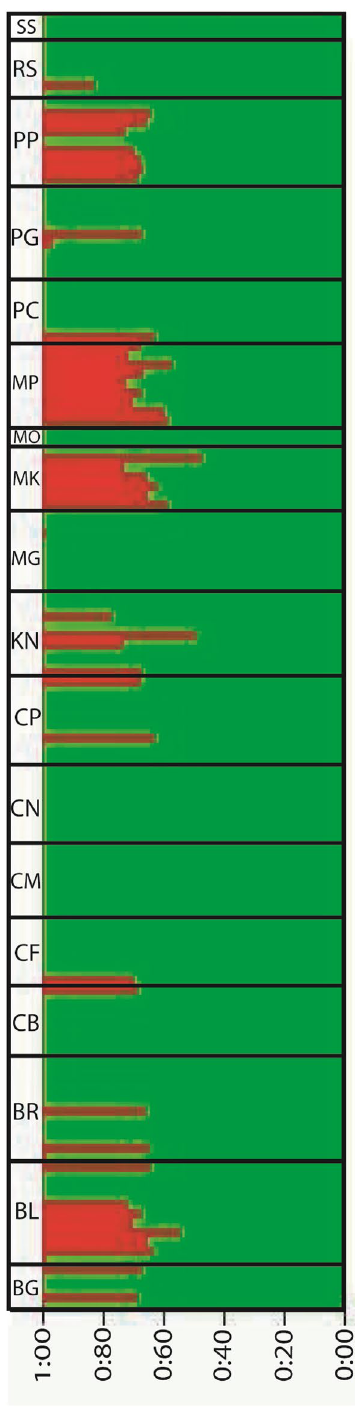
Figure 5. Structure analysis based on 842 SNP loci. CM, Chilmari; BG, Balashi Ghat; CN, Chapai-Nababganj; RS, Rajshahi; MO, Mohanganj; SS, Someshwari, Durgapur; MG, Manikganj; BR, Bhairab; CP, Chandpur ; KN, Khulna; PP, Pirojpur; BL, Bhola; MP, Mohipur; CF, Char Fasson; PC, Pokhkhir Char; PG, Patharghata; CB, Cox’s Bazar; MK,